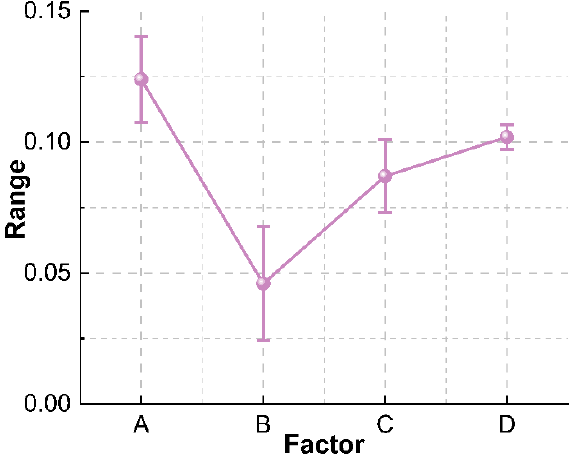
Figure 4. Representative results of compressive strength tests: ( a ) The shape of the test block damaged by compression; ( b ) The failure section of the specimen with a water-cement ratio of 0.3; ( c ) The foams are unstable and break when the blowing agent is diluted 50 times.